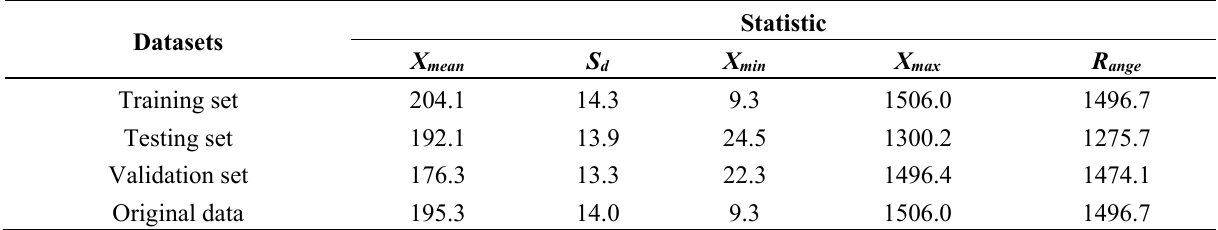
Table 1. The information of various datasets in Xinfengjiang